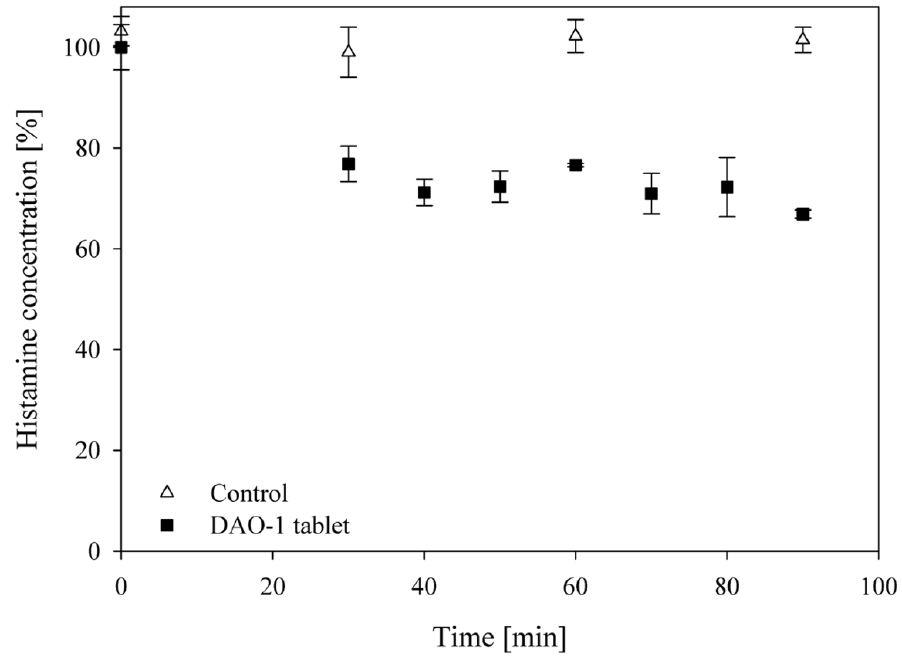
Figure 5. Bioconversion of 75 mg of histamine in food matrix SIF 3 by one DAO-1 tablet (690 nkat DAO-1). For the control, no DAO-1 tablet was applied. Histamine concentrations were determined by RP-HPLC.